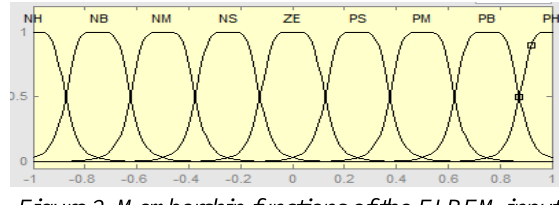
Figure 2. Membership functions of the FLREM input